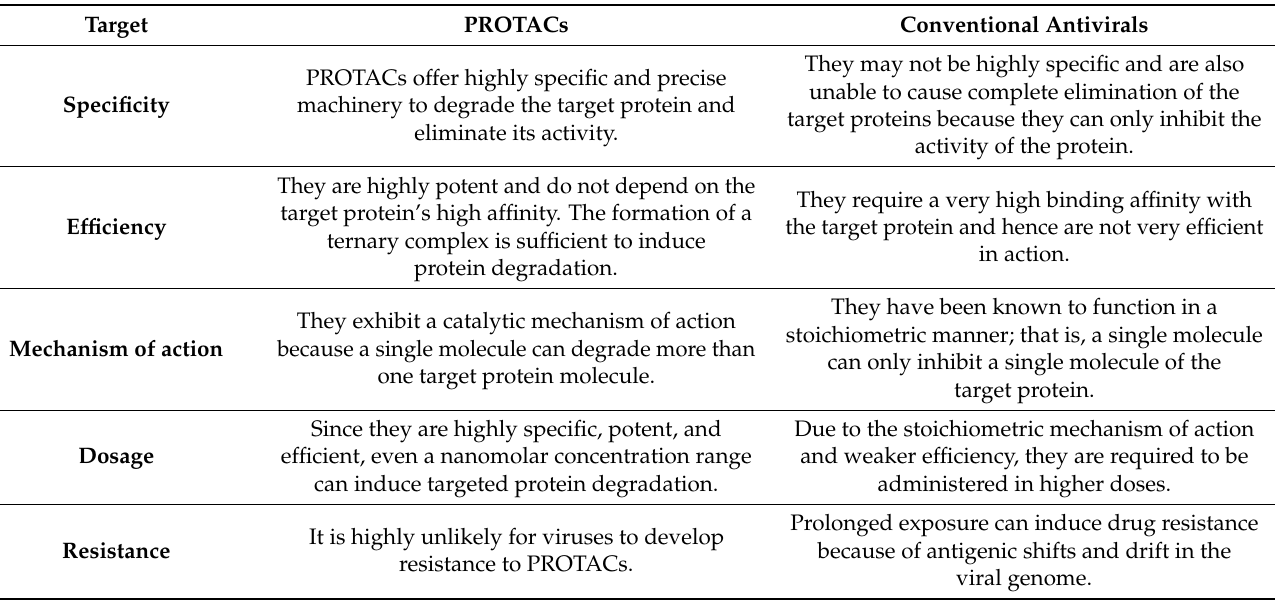
Table 2. Summary of advantages of PROTACs over other conventional